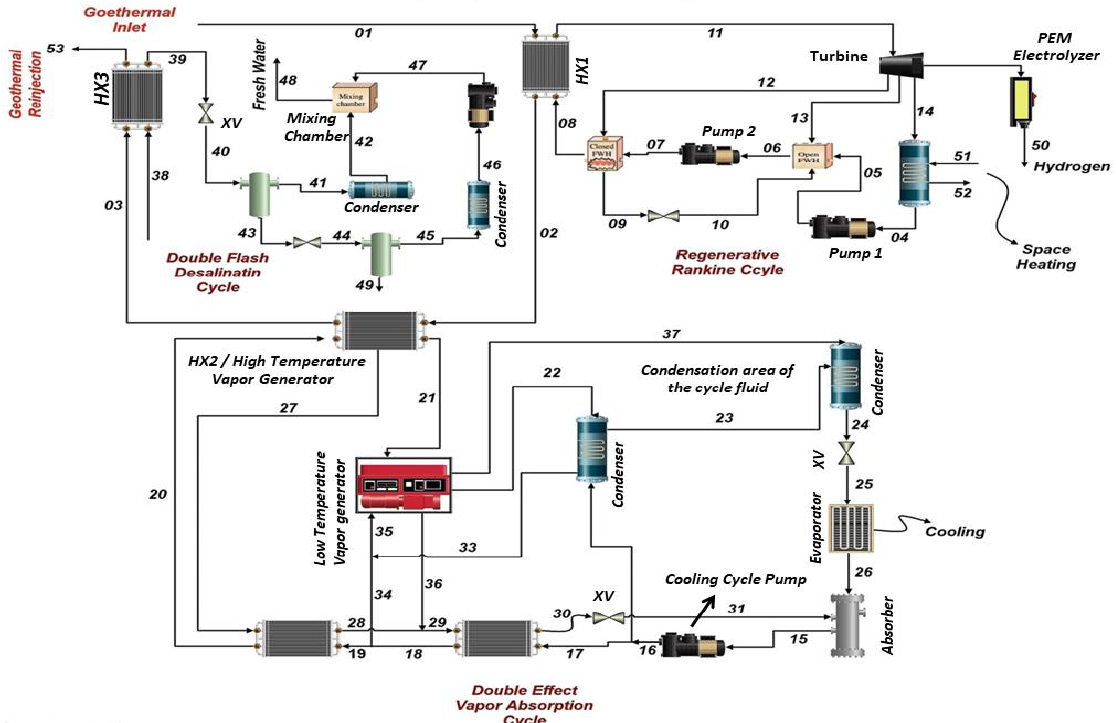
Figure 1. Schematic Diagram of Geothermal Sourced Multigeneration System.